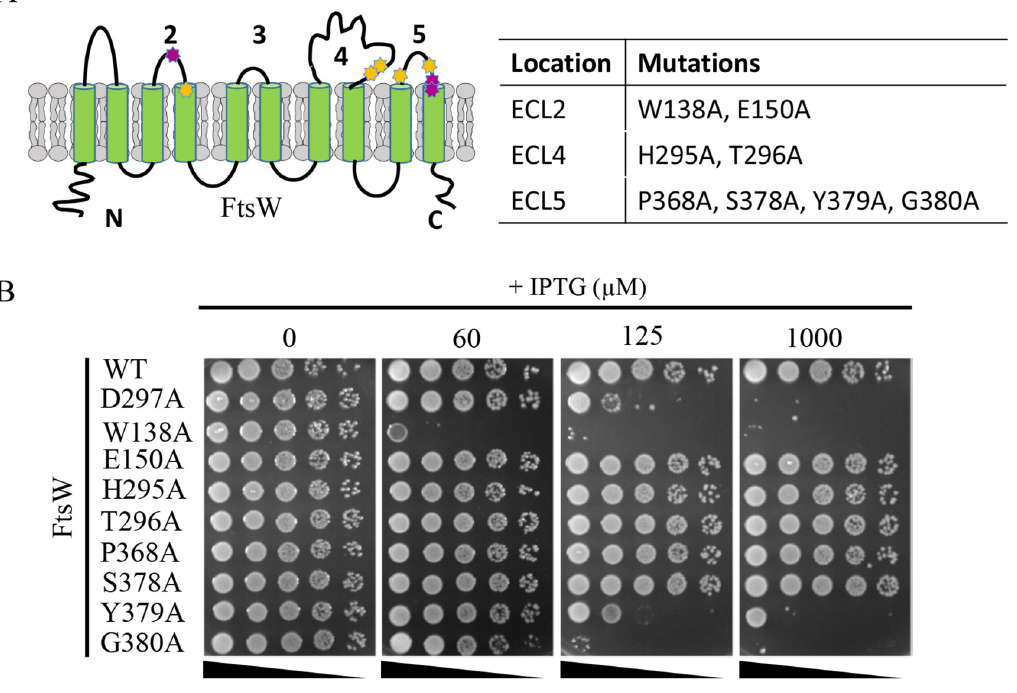
Fig 4. Isolation of additional dominant-negative mutations of FtsW. (A) Residues chosen for site-directed mutagenesis are indicated in the topology model of E . coli FtsW. Dominant-negative alleles are colored magenta, alleles that did not show an effect are colored yellow. (B) A spot test of the FtsW mutants. The test was performed as in Fig 1A.